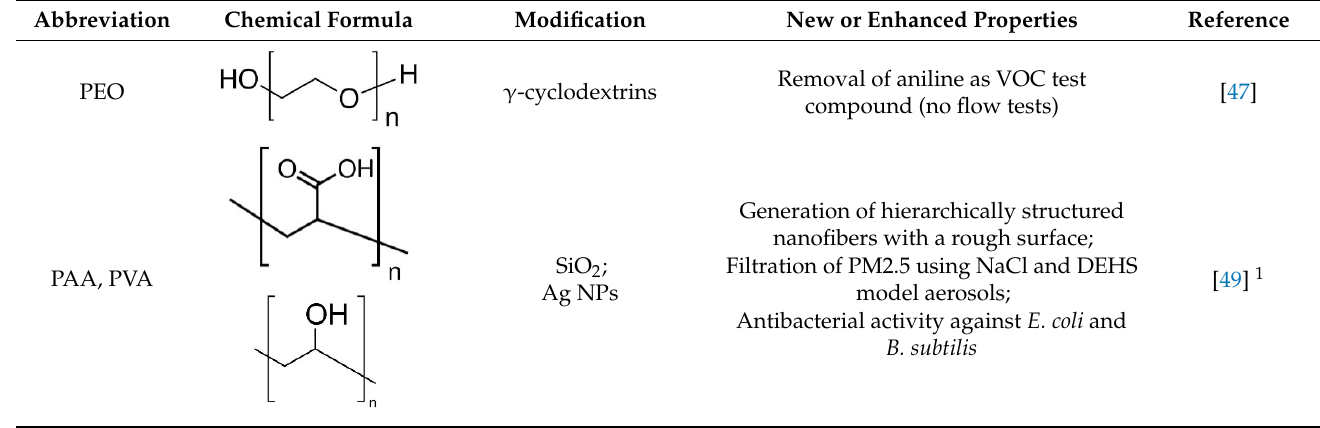
Table 1. Electrospun water-soluble synthetic polymers.